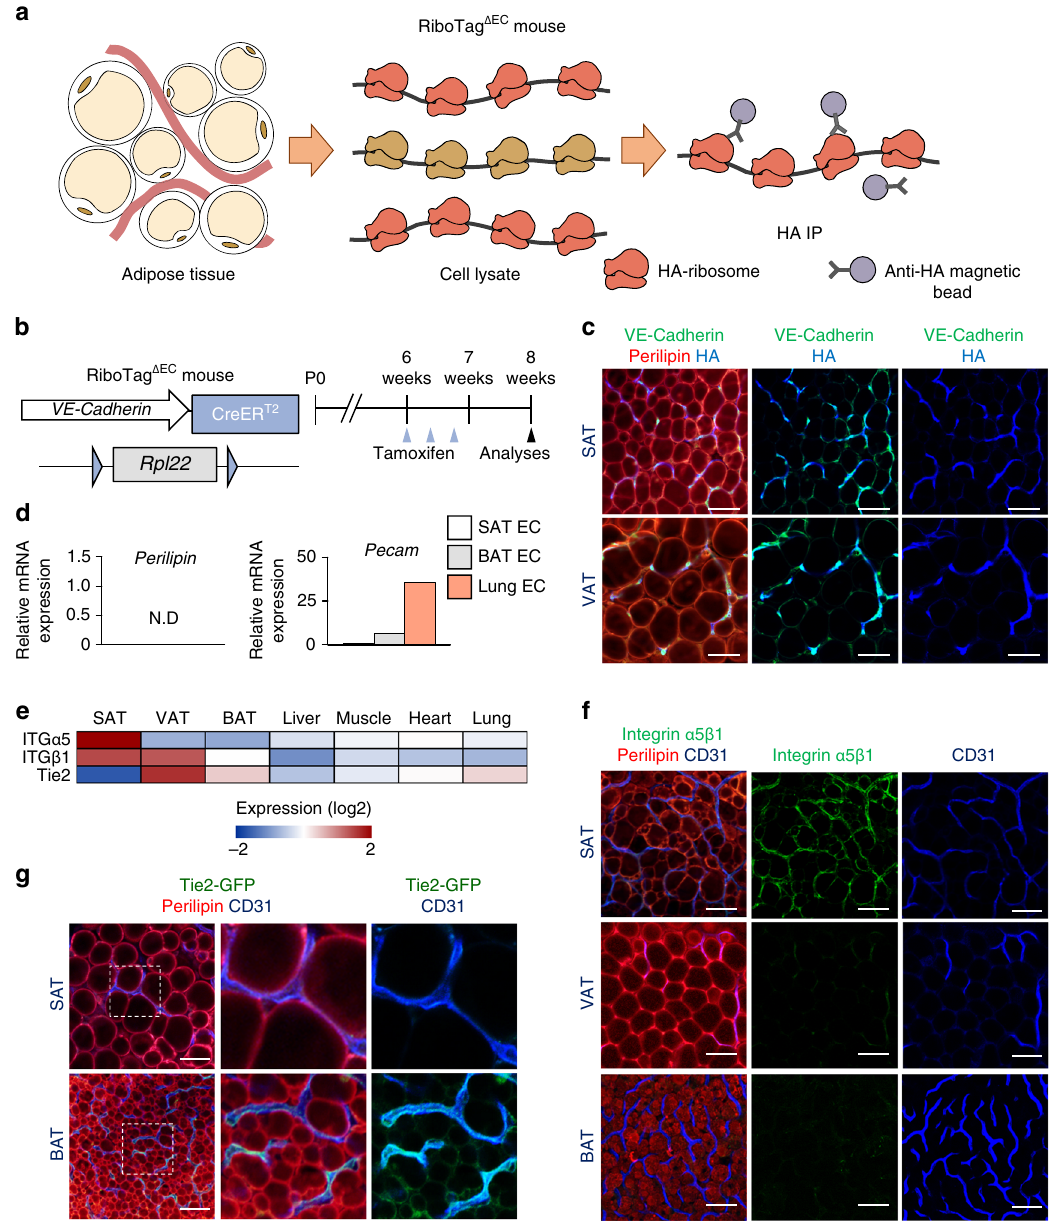
Fig. 3 ECs of SAT are enriched with integrin α 5 β 1. a Diagram depicting EC-speci fi c RiboTag transcriptome analysis. Inducible recombination of the RiboTag allele led to expression of hemaglutanin (HA)-tagged ribosomal protein (reddish orange) speci fi cally in ECs. Ribosome-bound transcripts were immunoprecipitated (IP) from homogenized whole tissues with anti-HA antibody-coupled magnetic beads. Extracted mRNAs were analyzed by RNA-Seq analysis. b Generation of RiboTag Δ EC mouse, inducible and speci fi c tagging of ribosomes in ECs in 6-week-old mice, and their analyses 2 weeks later. Red arrowheads indicate daily injections of tamoxifen. c Representative images of HA-tagged ribosomal protein in VE-Cadherin expressing ECs in adipose tissues of RiboTag Δ EC mouse. Scale bars, 50 μ m. d Comparisons of perilipin and pecam expression in isolated mRNA of ECs from different organs of RiboTag Δ EC mouse. e RNA-seq expression heatmap of ITG α 5, ITG β 1, and Tie2 in isolated ECs from different organs using RiboTag Δ EC mouse. n = 5 for each group. f Representative images of ITG α 5 β 1 expression in various adipose tissues of WT mice. Scale bars, 50 μ m. g Representative images of Tie2 expression in SAT and BAT of Tie2-GFP mice. Magni fi ed views of dotted-line box are shown in lower panels. Scale bars, 50 μ